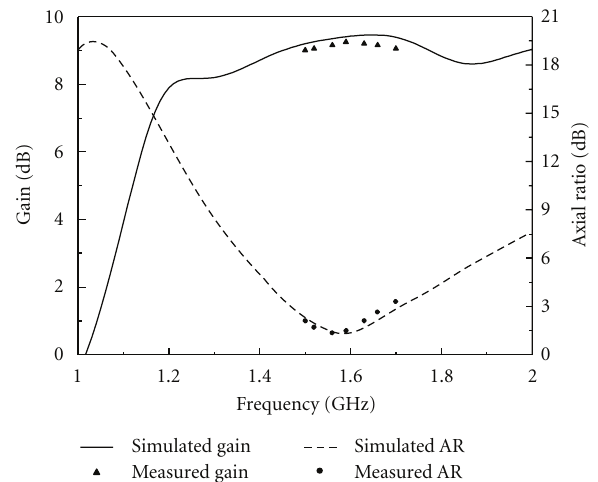
Figure 6: Simulated and measured gain and axial ratio at the boresight.